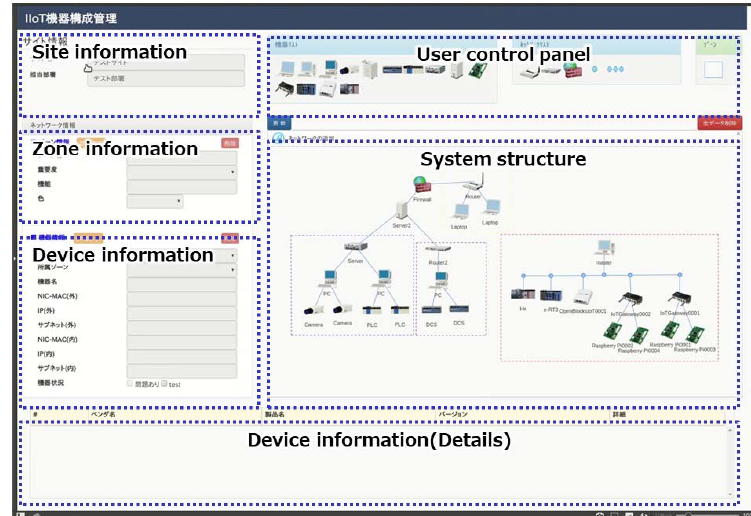
Figure 5. GUI example for asset configuration management.